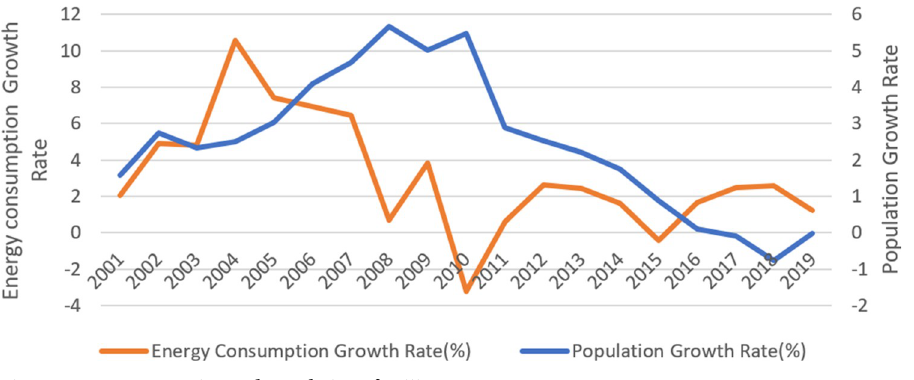
Fig 4. Energy consumption and population of